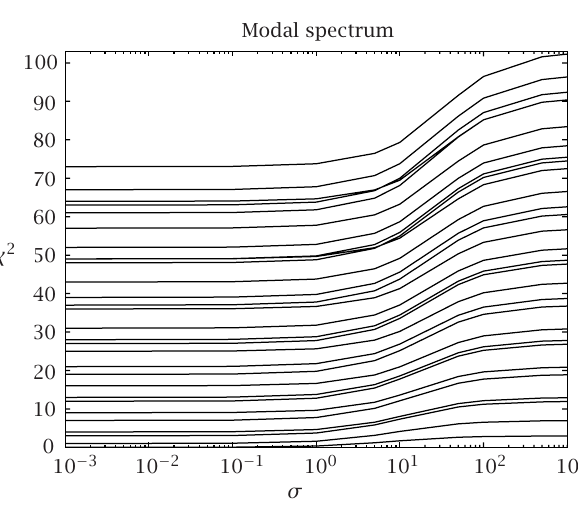
Figure 8.1 . Spectral